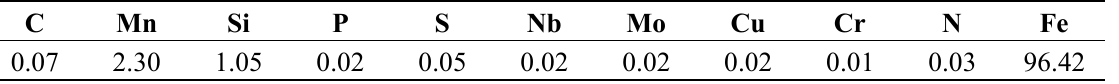
Table 1. Chemical composition (wt %) of the flat specimen provided by the